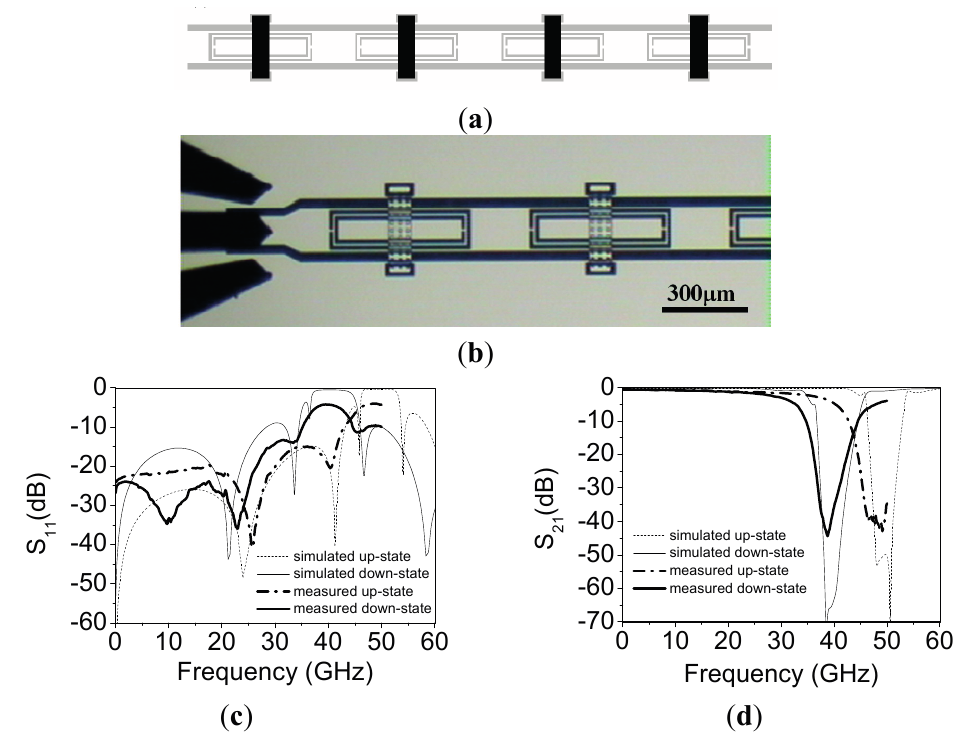
Figure 4. Layout of the fabricated tunable stopband filter ( a ), microphotograph of the first two stages of the filter, including RF probes ( b ), simulated and measured insertion losses ( c ), and simulated and measured return losses ( d ). The simulations were done by considering plate heights of 0.5 μ m and 2 μ m for the down and up-state, respectively. From [17], reprinted with